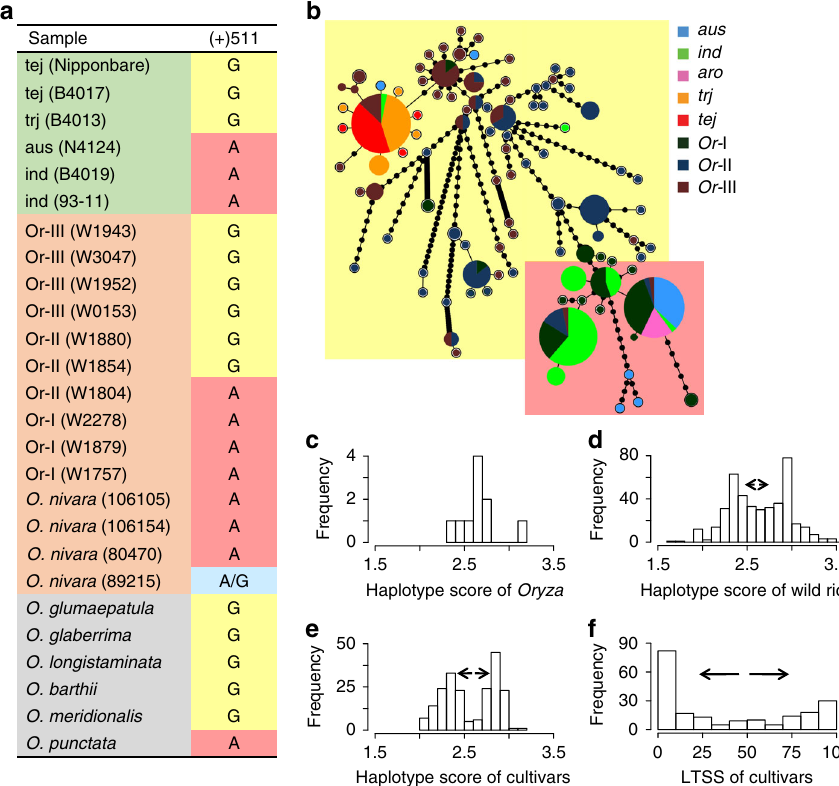
Fig. 5 Phylogenetic analysis of the bZIP73 gene. a Multiple DNA sequence alignments of 26 OsbZIP73 genes. Nucleotide sequences of the FNP ( + 511 nt; the fi rst nt of the coding region was de fi ned as + 1) are shown. Samples in the green background are cultivated rice; brown background indicates common wild rice O . ru fi pogon and O. nivara ; gray background indicates other wild rice relatives. Tej, temperate japonica ; trj, tropical japonica , ind, indica ; aro, aromatic ; Or, O. ru fi pogon . b Phylogenetic network of bZIP73 genes with yellow and pink backgrounds denoting haplotypes carrying the bZIP73 Jap and bZIP73 Ind genotypes, respectively. The size of each node is proportional to the sample size. c – e Haplotype score distributions of AA-genome wild rice ( c ), O. ru fi pogon ( d ), and cultivated rice ( e ). f Phenotypic distribution of low-temperature seedling survivability (LTSS) of cultivated rice accessions. Arrows indicate the trend of genotypic or phenotypic differentiation